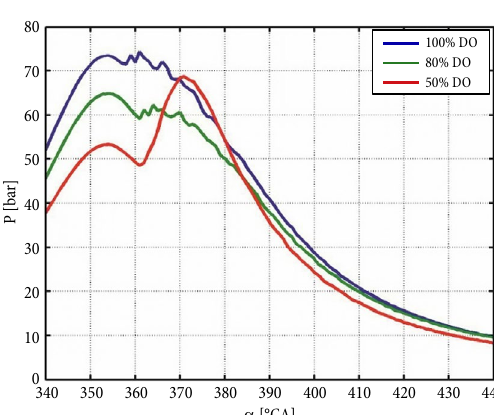
Fig. 10. Average relative error of pressure measurement versus CA; for dual-fuel operation; n = 3400 rpm; T = 50 Nm (at different proportions of diesel